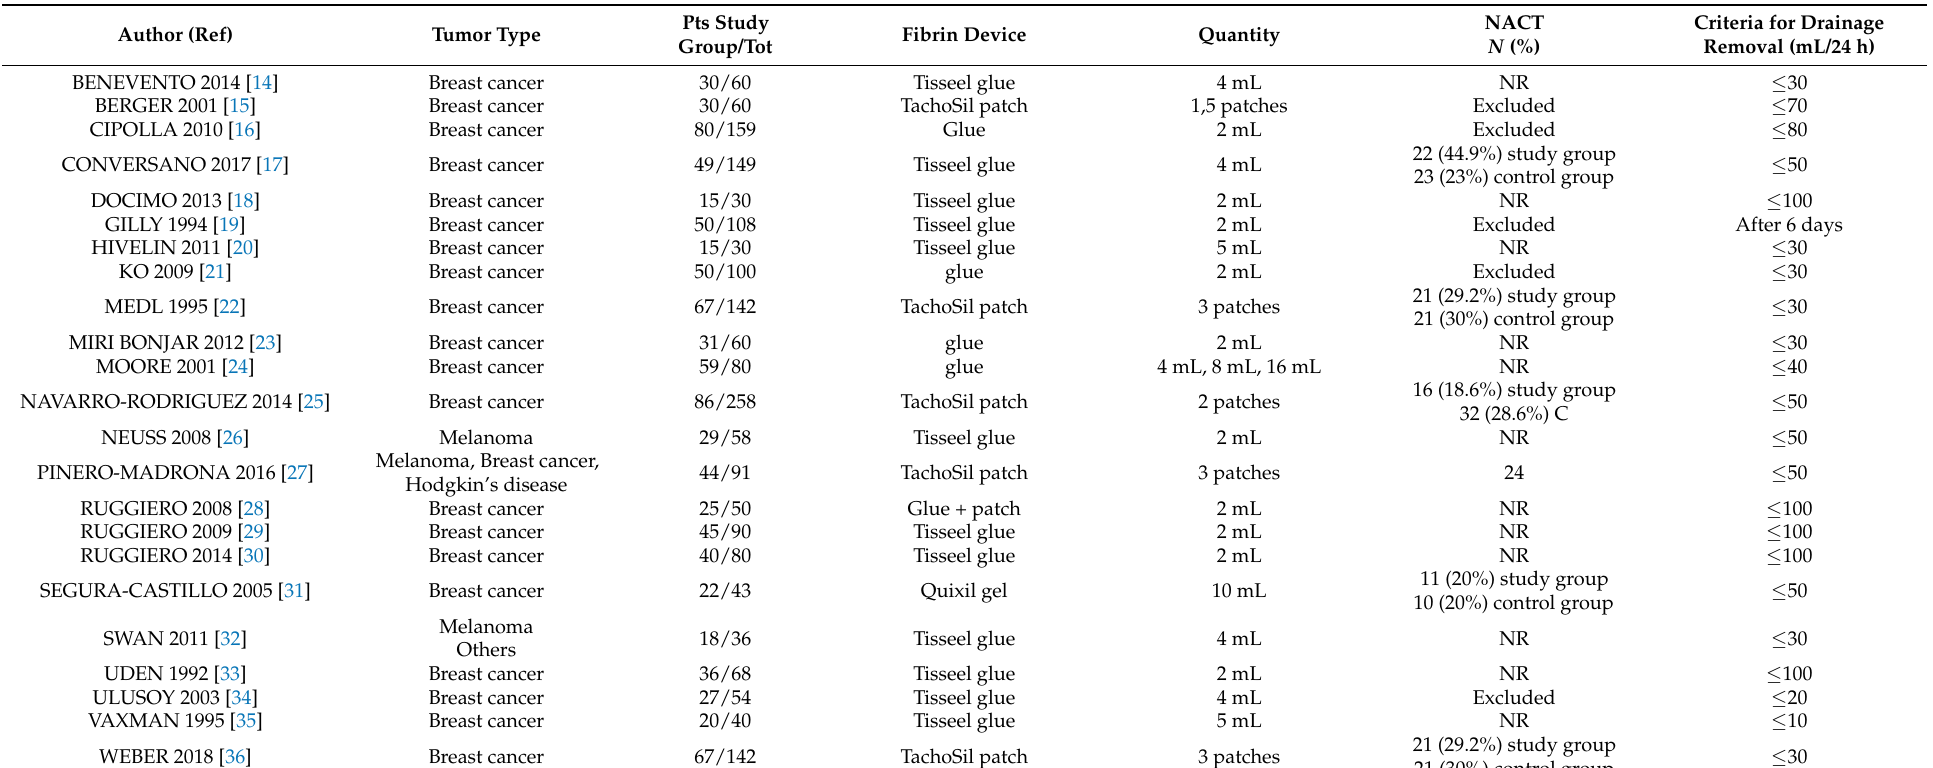
Table 1. Characteristics of the clinical randomized